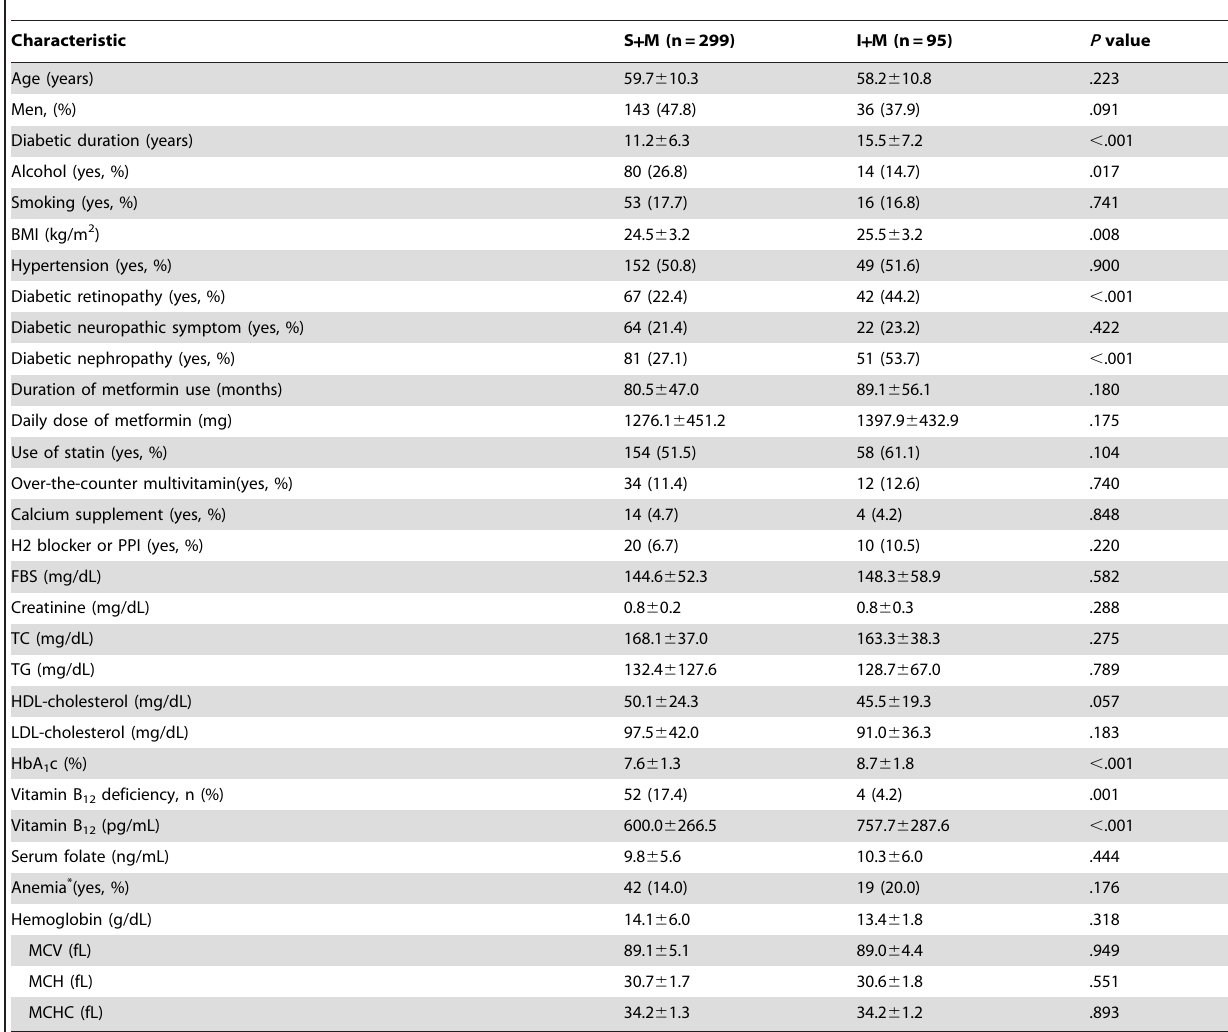
Table 2. Characteristics of the subjects according to combination treatment with